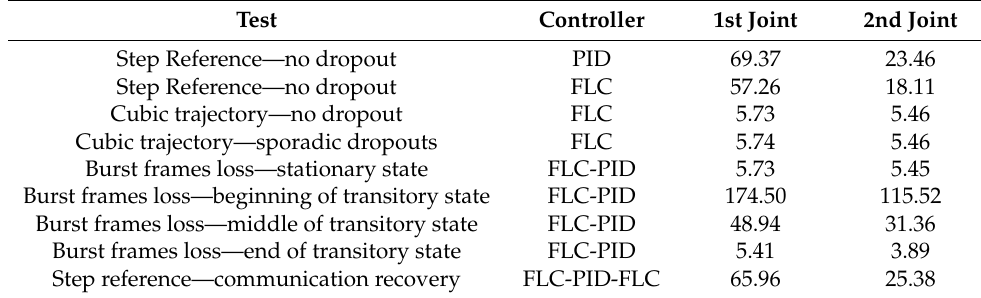
Table 9. Summary of IAE for all